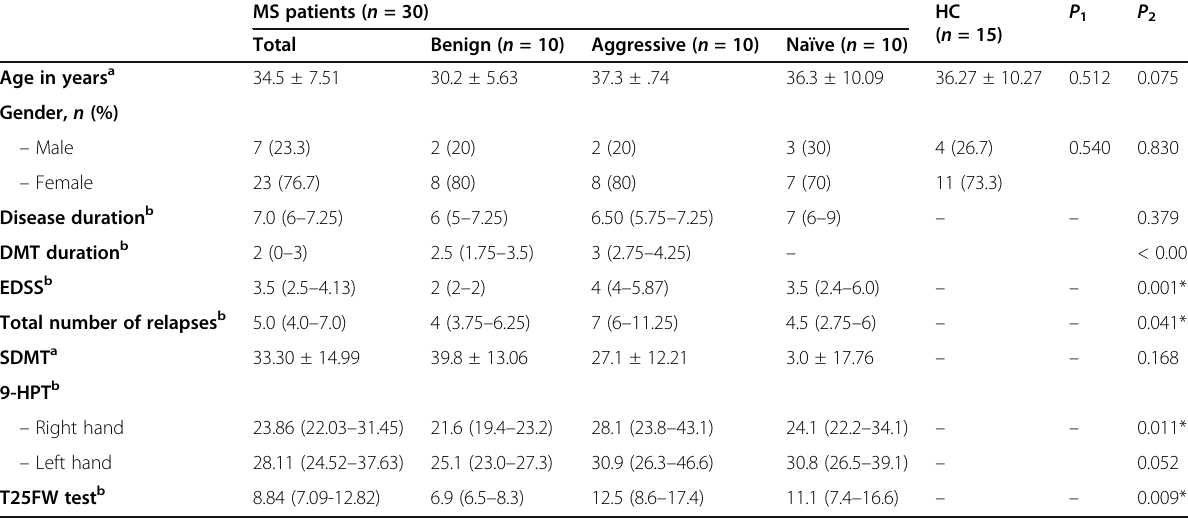
Table 1 Sample descriptive analysis ( n = 45)